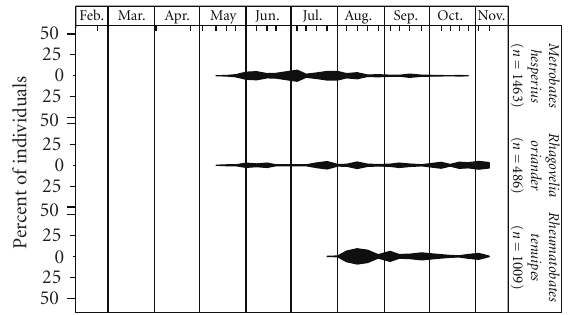
Figure 8: Percent of total individuals of each species ( Metrobates hesperius , Rhagovelia oriander , and Rheumatobates tenuipes ) across all sample